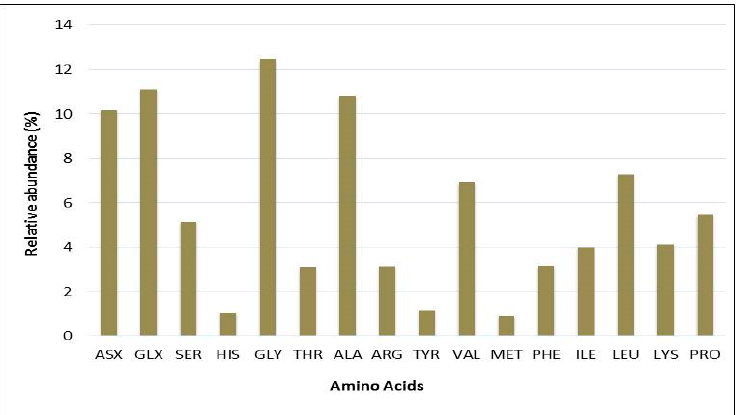
Figure 3. Percentages of total amino acid derivatives of Chlorella sp. QUCCCM3 protein lysate, obtained using the pre-column PITC labeling method, analyzed via HPLC-UV. ASX: Aspartic acid;